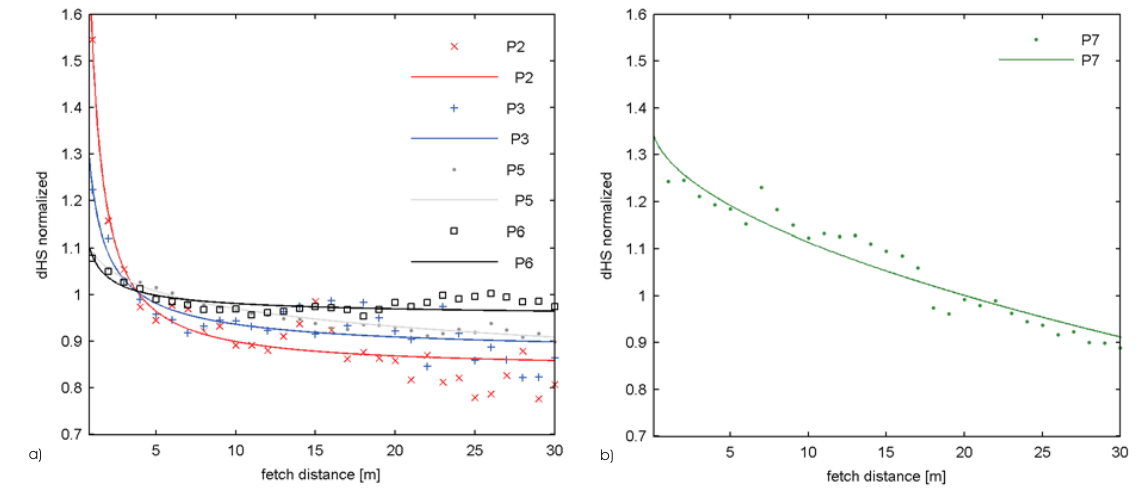
Fig. 3. Normalized averaged snow-depth changes per distance class of 1m in fetch distance from area-wide measurements of periods P2, P3, P5, P6 (a) and from an isolated snow patch at 11 April 2011 (b) .